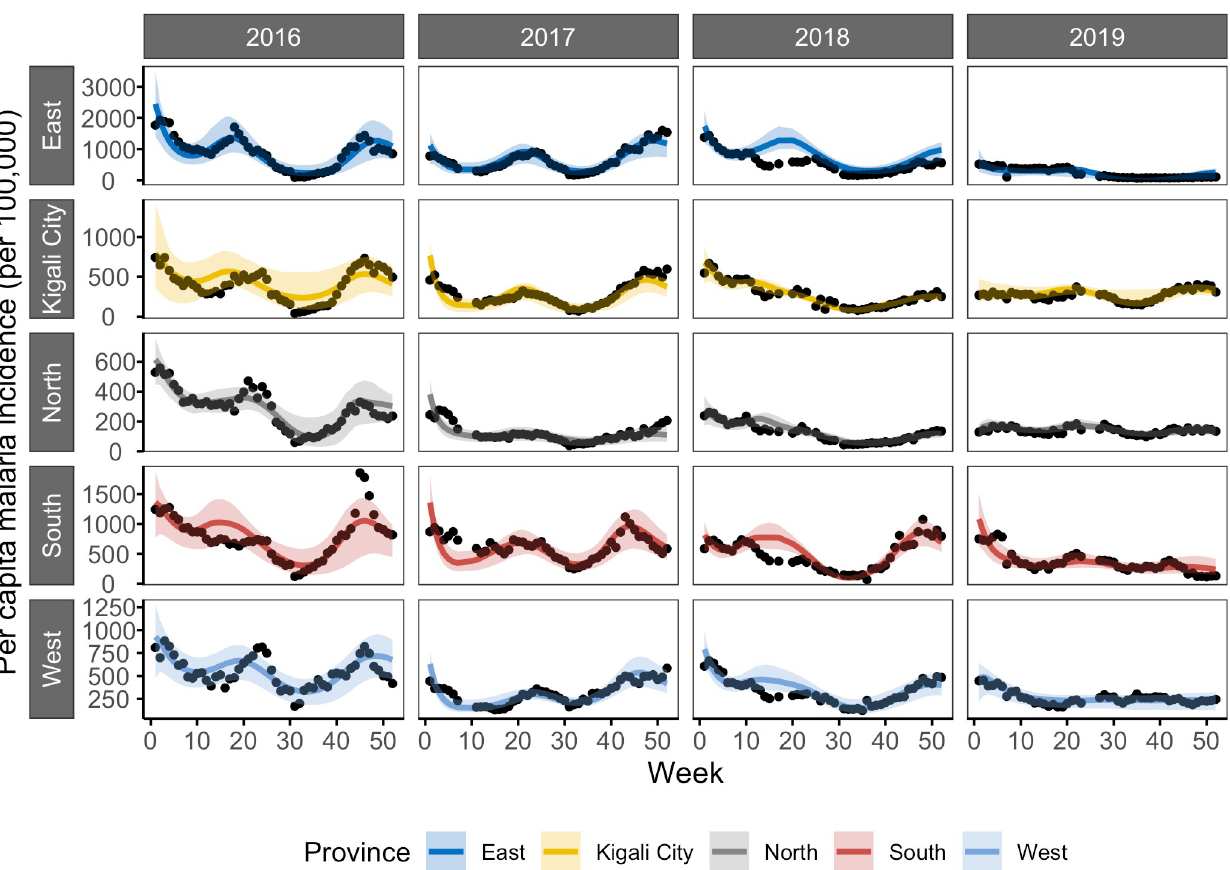
Fig 4. Incidence of malaria as simulated by the model-EAKF system under yearly initialization. The aggregated results (per capita incidence) from simulations of malaria transmission using the model-EAKF system, while re-initializing each year separately. On the y-axis of each panel, corresponding to different provinces, reported incidence is shown as black dots, while model-EAKF fittings are shown in colored lines. Colored shading indicates the spread of the 95% CI of model estimated incidence. Aggregated simulations for sites in the East, Kigali City, North, South and West provinces are indicated in blue, yellow, grey, red and light blue, respectively.